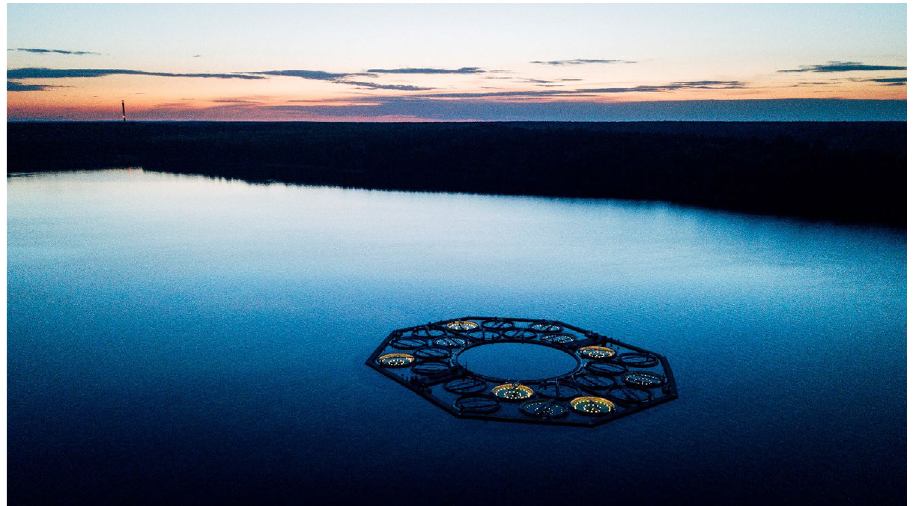
Figure 6. The illuminated LakeLab. Aerial photograph of the LakeLab in Lake Stechlin, Germany, with five enclosures each illuminated by high and low levels of emulated skyglow, respectively. (image credit: V.